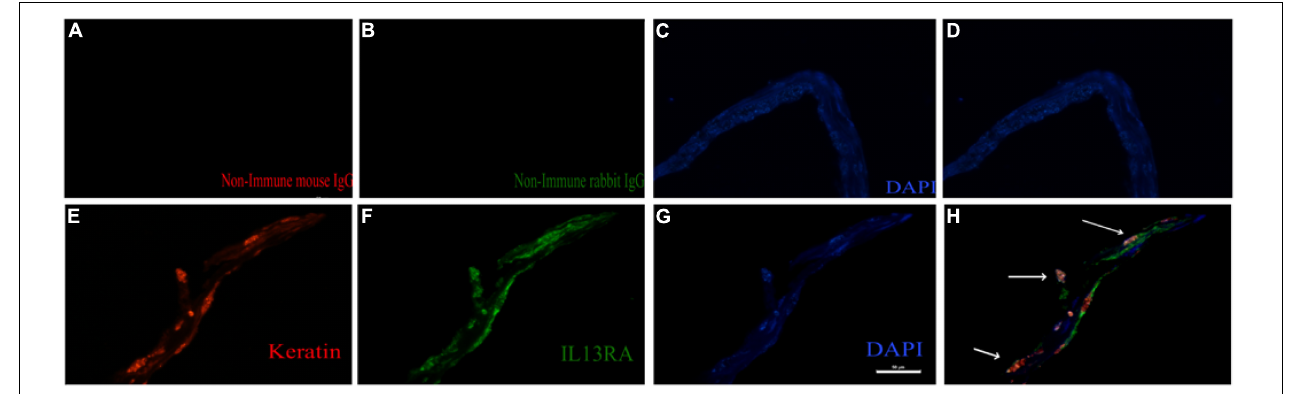
FIGURE 6 | IL13R α 2 is highly expressed in RPE cells within epiretinal membranes from patients with proliferative vitreoretinopathy (PVR). Fibrotic epiretinal membranes from patients with PVR were first incubated with primary antibodies: a mixture of non-immune mouse and rabbit IgGs (A–D) , or of anti-IL13R α 2 and pan keratin antibodies (E–H) at 4 ◦ C overnight, and then with fluorescently labeled secondary antibodies at 1 h in room temperature. Co-staining of IL13R α 2 with pan keratin in H indicates IL13R α 2 expression in RPE cells in the ERMs from patients with PVR. Scale bar: 50 µ m.